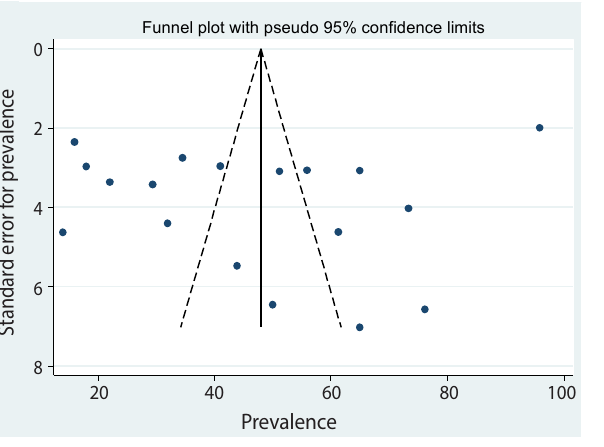
Figure 5. Funnel plot of the studies included in the meta-analysis.